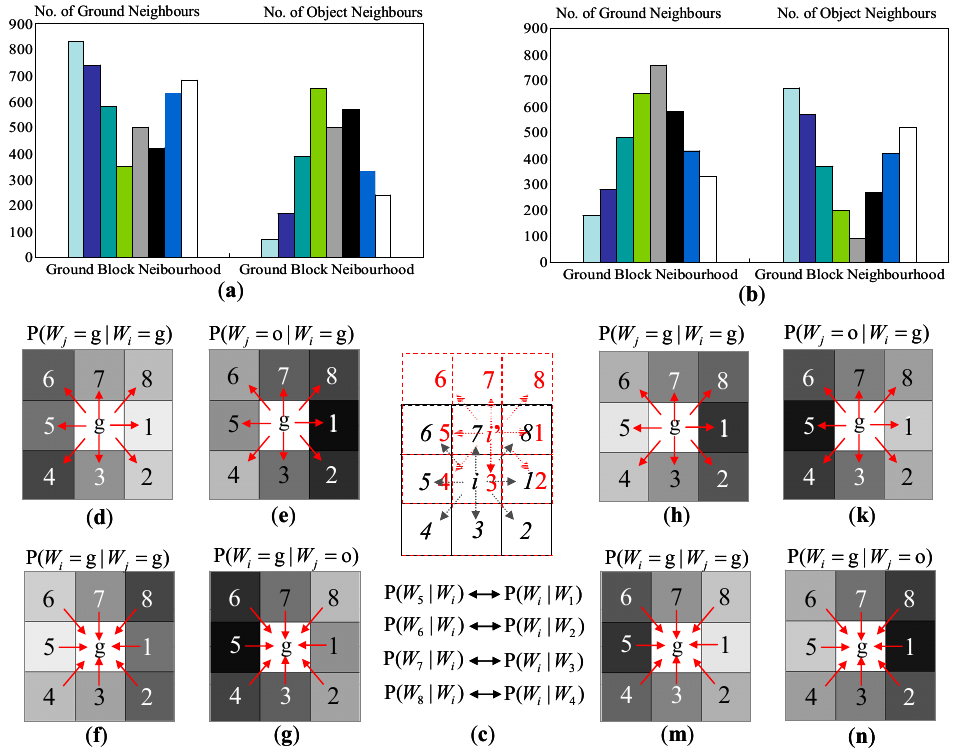
Figure 11. Spatial context prototype built from a neighbourhood histogram. ( a ) Neighbourhood histogram for the left half of the image; ( b ) Neighbourhood histogram for the right half of the image; ( c ) Transfer of neighbourhood dependency relations; ( d )–( g ) Spatial context prototypes for the left half of the image; ( h )–( n ) Spatial context prototypes for the right half of the image.